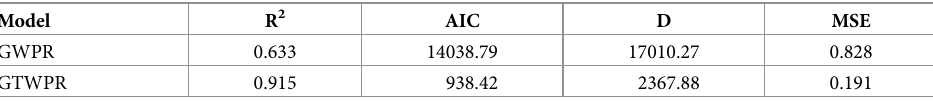
Table 4. The comparison of models (3) and (4).